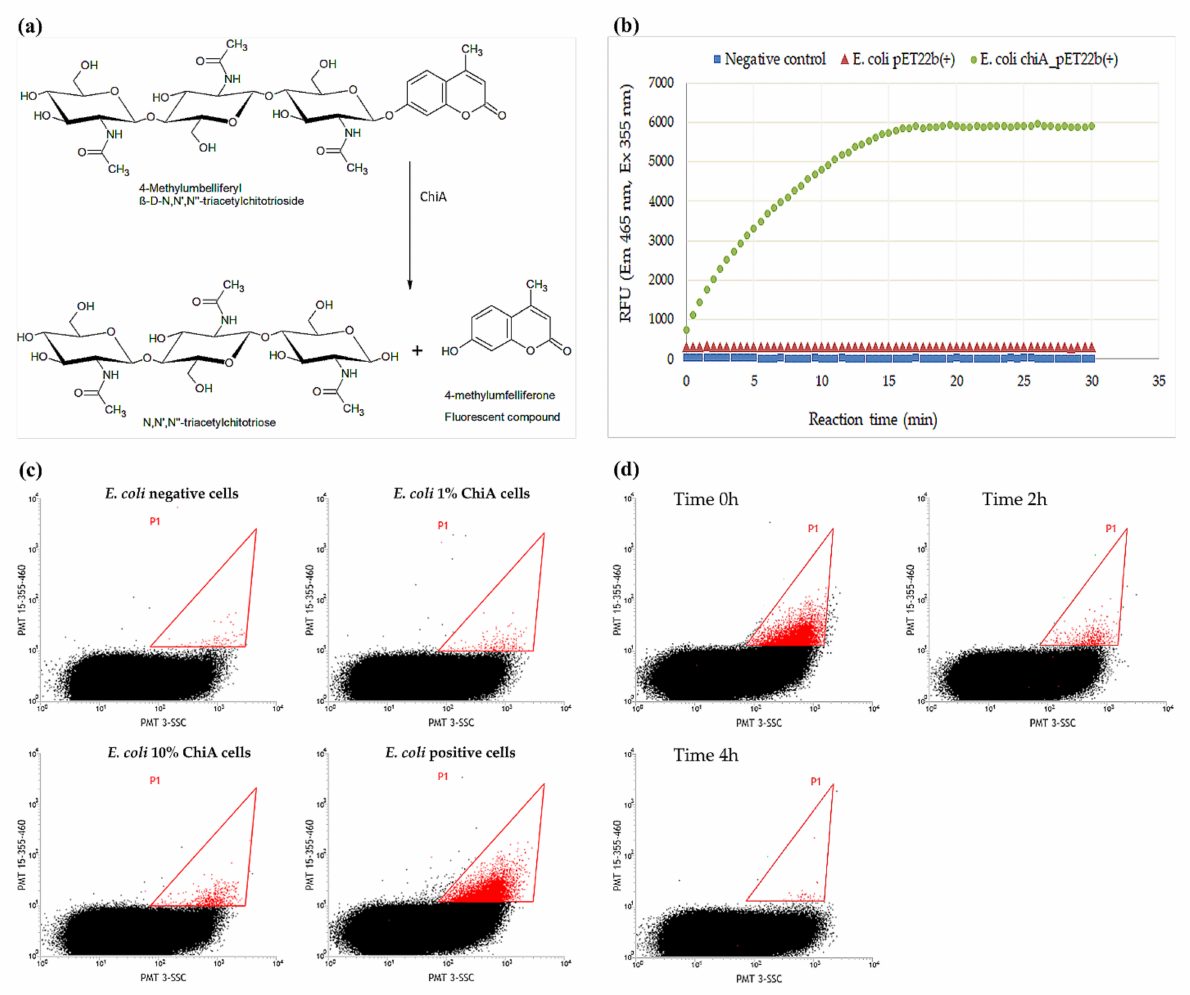
Figure 1. The synthetic fluorogenic substrate 4-methylumbelliferyl β - D - N , N (cid:48) , N (cid:48)(cid:48) -triacetyl chitotrioside (4MUTC) was used for the detection of chitinase activity. ( a ) ChiA cleaves 4MUTC to generate the fluorescent product 4-methylumbelliferone (4MU) and N , N (cid:48) , N (cid:48)(cid:48) -triacetylchitotriose. ( b ) MTP fluorescence assay using 4MUTC as the substrate for ChiA. ( c ) FACS response of E. coli cells containing ChiA in emulsions. Samples comprising 100% positive ( E. coli chi A_pET22b+) or 100% negative cells ( E. coli pET22b+) as well as samples comprising different proportions of positive and negative cells were tested. The positive droplet population is shown in red. ( d ) Decay of the FACS response of E. coli cells containing ChiA over time, in double